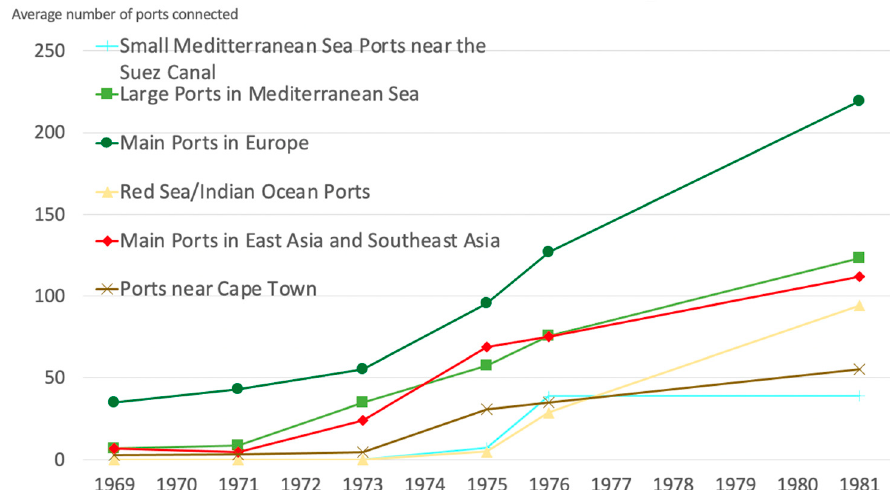
Figure 12. Average number of ports connected for each regional group.